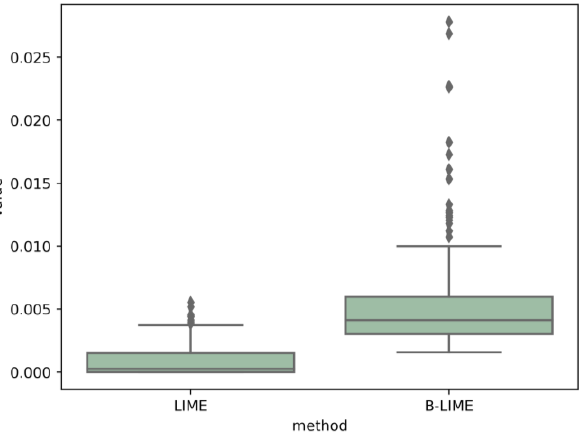
Figure 9. Boxplot differences of results.